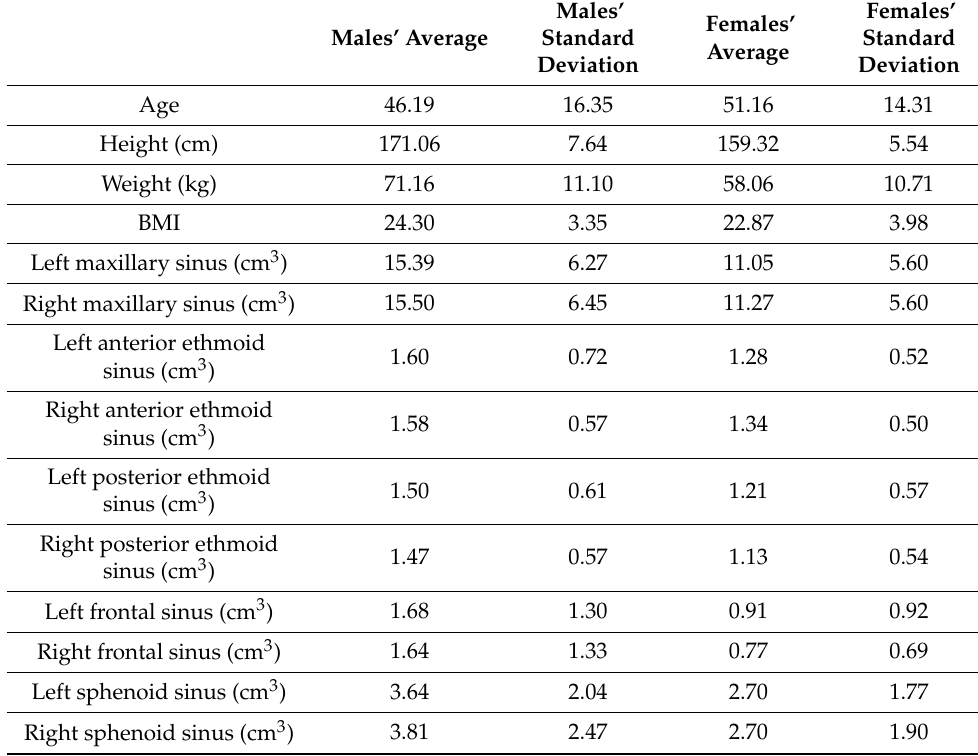
Table 7. Nasal sinus volume comparison